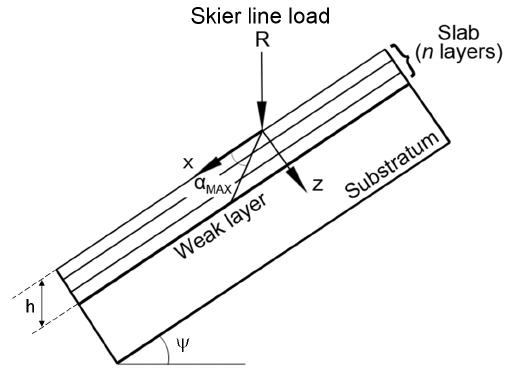
Figure 1. Cross section of a slab showing R as the skier load, ψ the slope angle, h the slab depth and α max the angle from the skier to the maximum induced shear